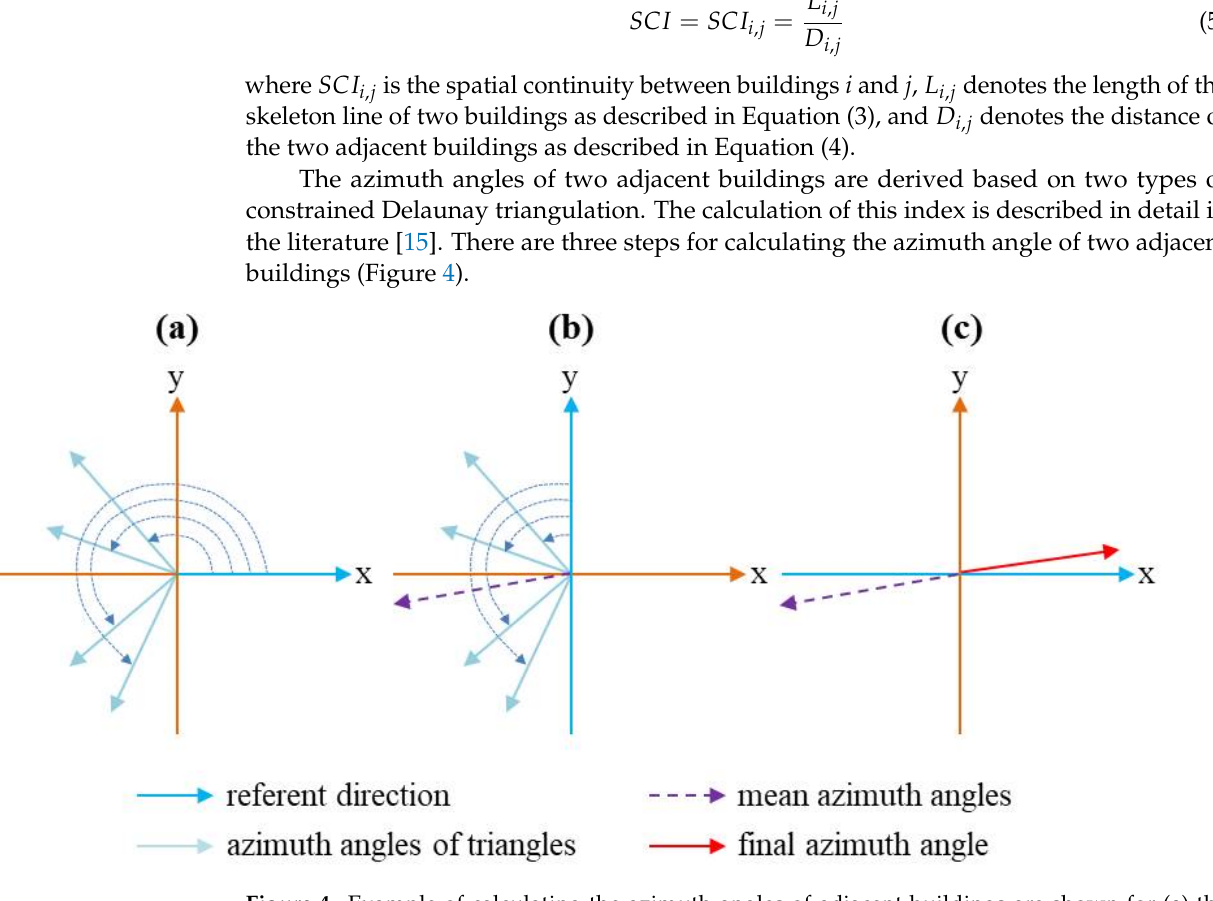
Figure 4. Example of calculating the azimuth angles of adjacent buildings are shown for ( a ) the azimuth angles of all triangles; ( b ) the mean azimuth angle of two adjacent buildings; ( c ) the final azimuth angle of two adjacent buildings.